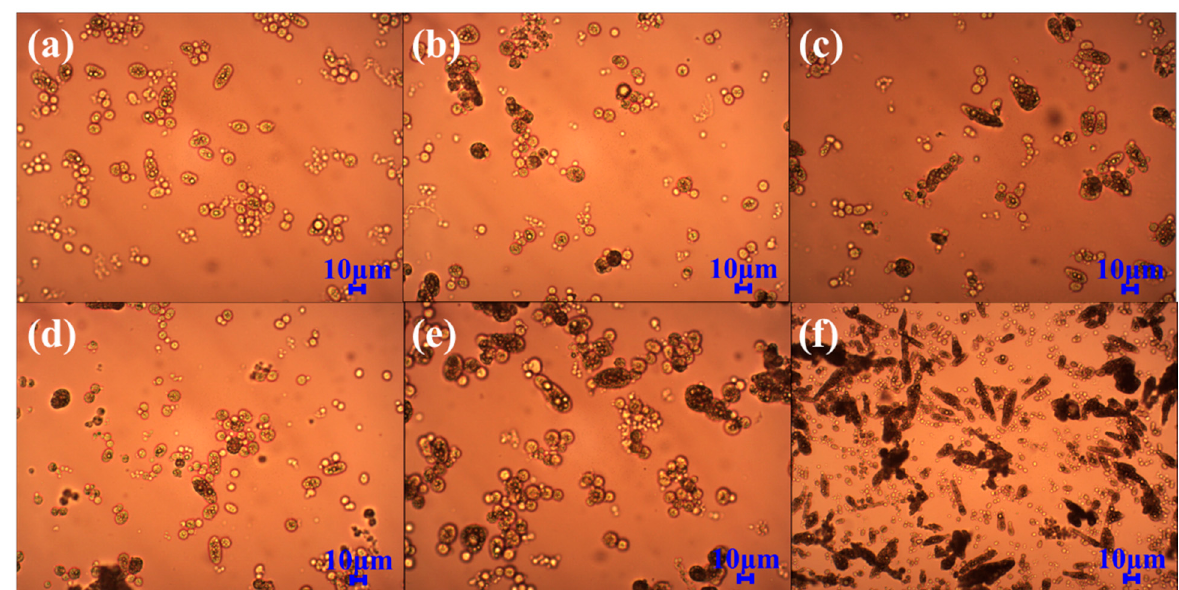
Figure 6. Effect of wall material concentration on the formation of the OMC microcapsules, recorded by DLS with a Zetasizer Nano ZS with ×400. ( a ) 1%, ( b ) 1.2%, ( c ) 1.4%, ( d ) 1.6%, ( e ) 1.8%, ( f ) 2.0%.